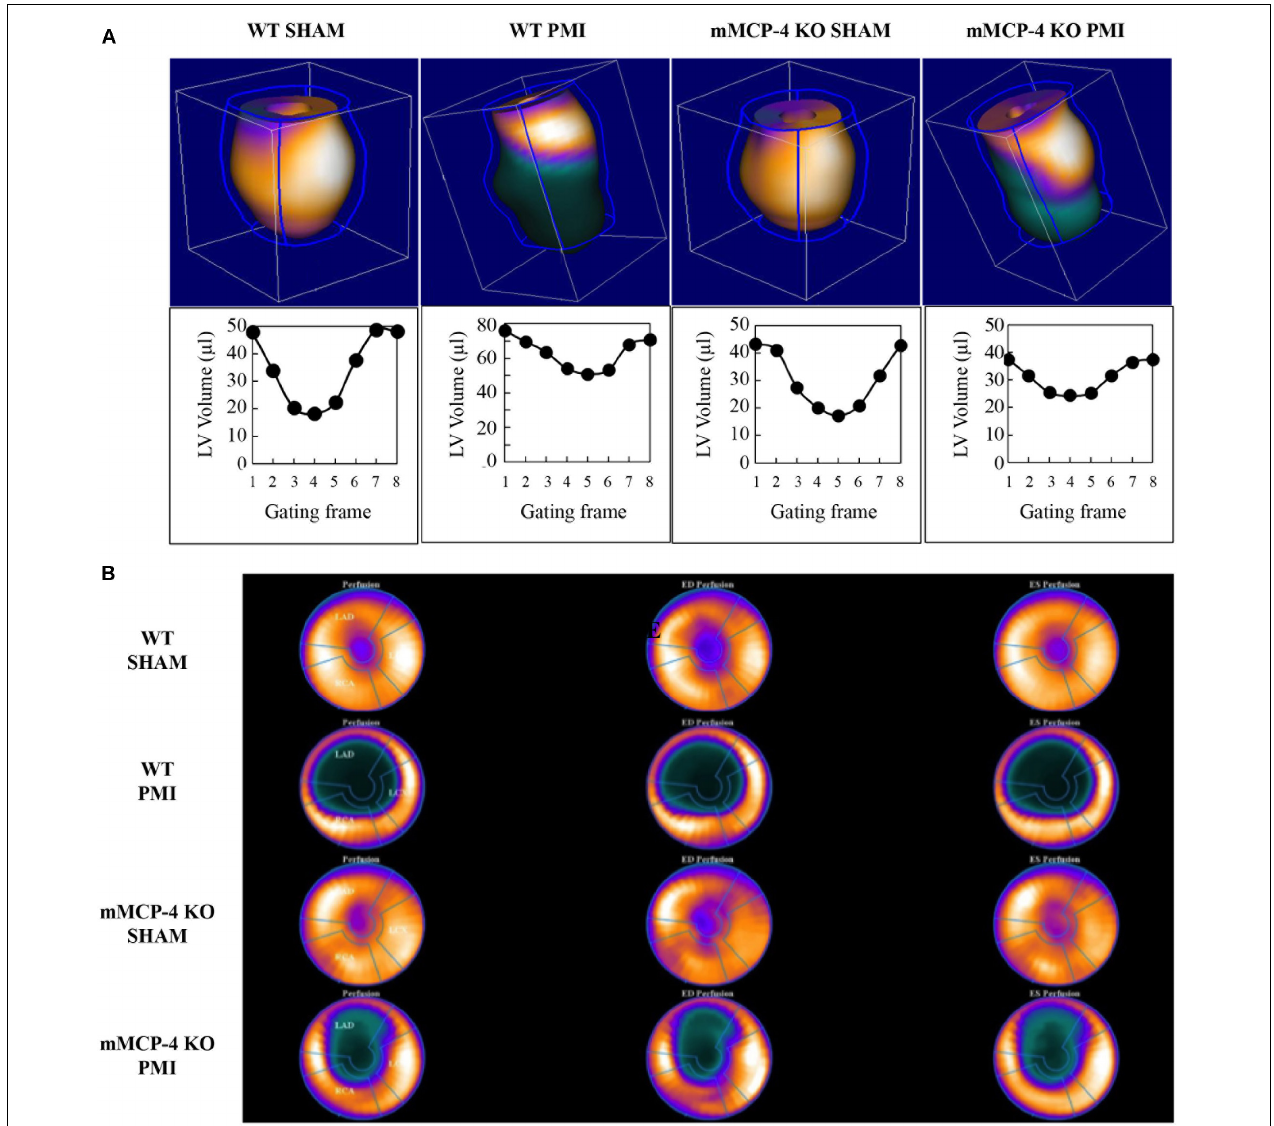
FIGURE 2 | Representative cardiac PET imaging of mouse hearts after PMI (A) . Mouse hearts were imaged 3 days following surgery with 18 F-FDG, and 3-dimension images were reconstructed. Below each reconstructed image is the ECG-gated left ventricular volume, measured through eight time points of the cardiac cycle (gating frames) for the same mouse. Polar maps of the mouse hearts were calculated, with the apex in the center, for the calculation of the infarcted area (B) .